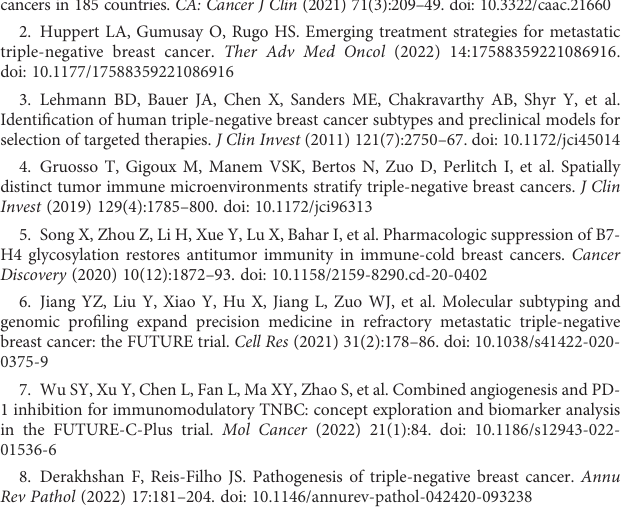
SUPPLEMENTARY FIGURE 1 Functional enrichment for ICG-related genes using GO annotation analysis. SUPPLEMENTARY FIGURE 2 Functional enrichment for ICG-related genes using KEGG annotation analysis. SUPPLEMENTARY FIGURE 3 Multivariable Cox-regression analysis adjusting for stage, IRS and the in fi ltration of immune cells. SUPPLEMENTARY FIGURE 4 Correlation analysis between ICGs-related riskscore and the level of M0 macrophages, M1 macrophages and M2 macrophages. SUPPLEMENTARY FIGURE 5 The relationship between CD8 T cells in fi ltration and IRS model genes by other immune-cell in fi ltration algorithms. SUPPLEMENTARY FIGURE 6 Correlation analysis between IRS and the stemness index DNAss and RNAss. SUPPLEMENTARY FIGURE 7 Drug sensitivity analysis in different IRS